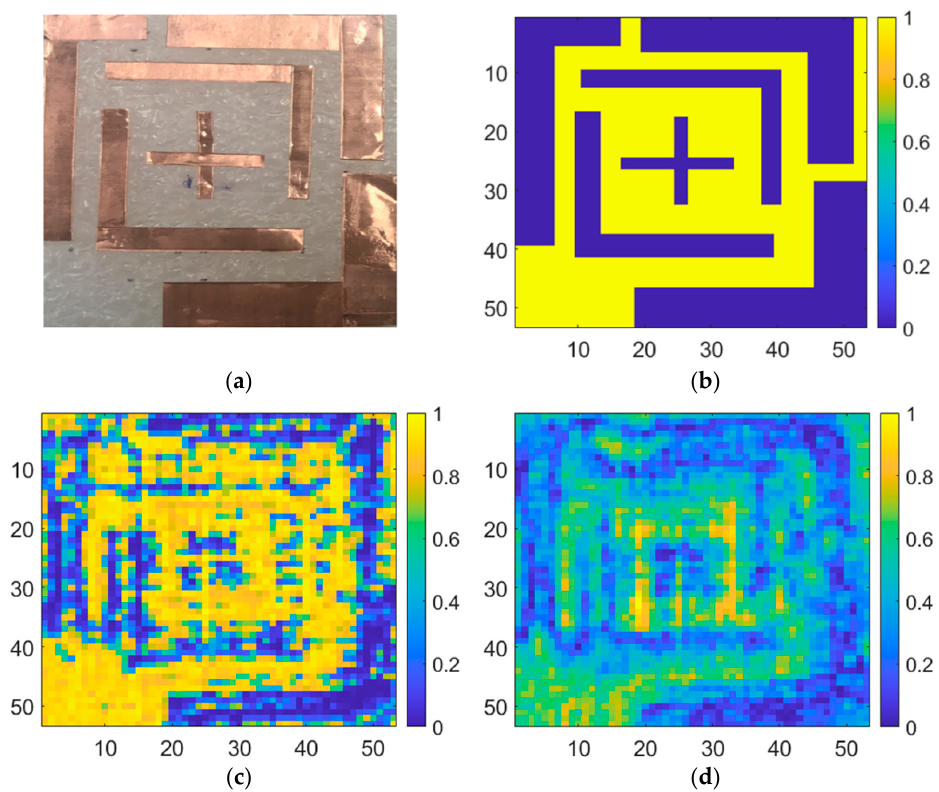
Figure 13. Sub-THz imaging in the previous study [23]. ( a ) Photograph of a real sample; ( b ) digitized image; ( c ) using a common-source detector circuit with the standard capacitors in the process design kit; ( d ) using a common-source detector circuit with the customized capacitors.